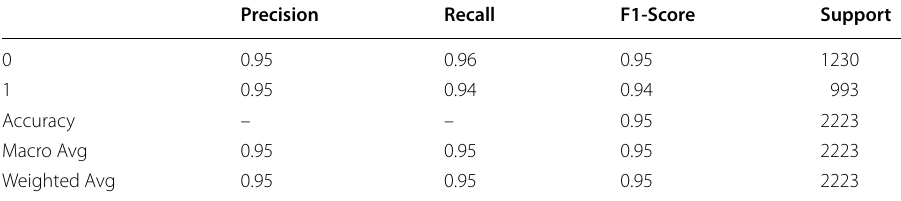
Table 4 Experiment 1 with AraSenTi dataset